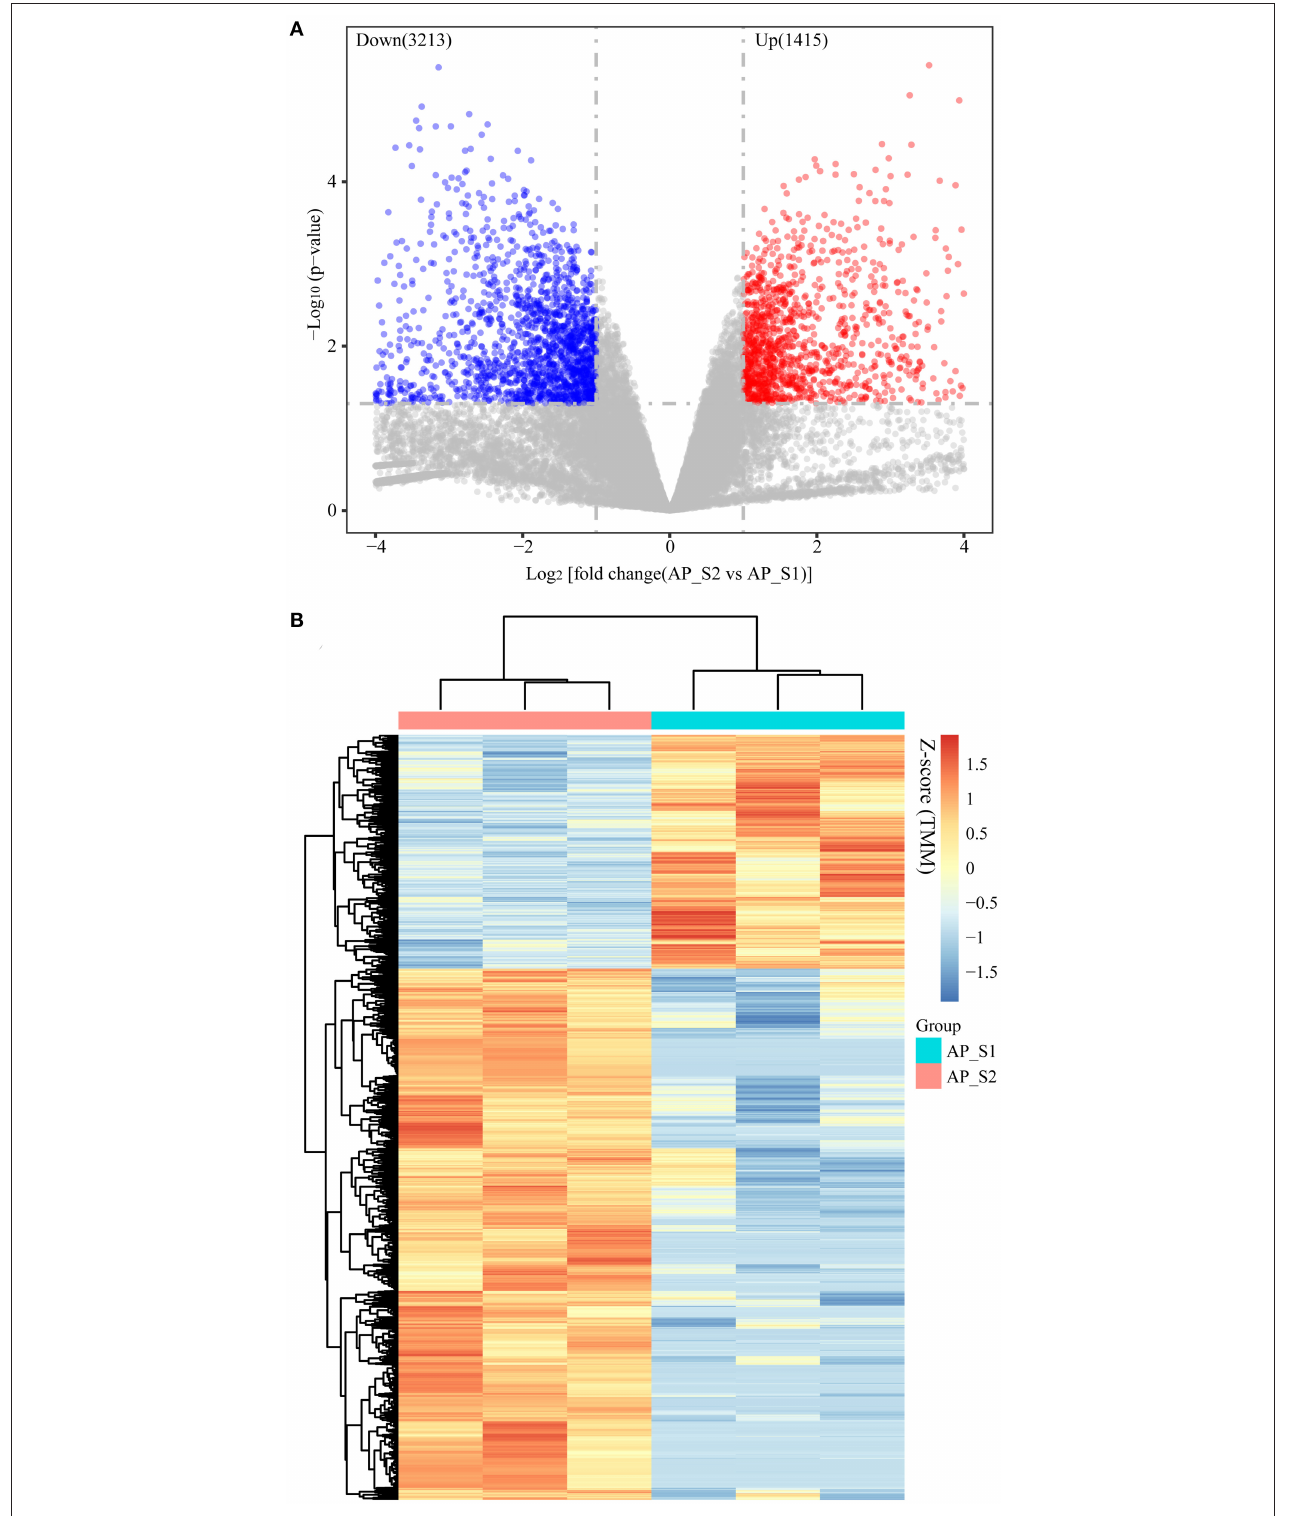
FIGURE 3 | Distribution of the differentially expressed genes (DEGs) in the two different harvesting periods of A. polytricha . (A) Volcano plot of the DEGs in the two different harvesting periods of A. polytricha . The horizontal axis shows the log2-fold change of unigenes between the two periods. The -log10 ( p -value) is plotted on the vertical axis. Each unigene is represented by one point on the graph. (B) Heatmap of the DEGs in the two different harvesting periods of A. polytricha expressed as z -score of the trimmed mean of M-values (TMM).